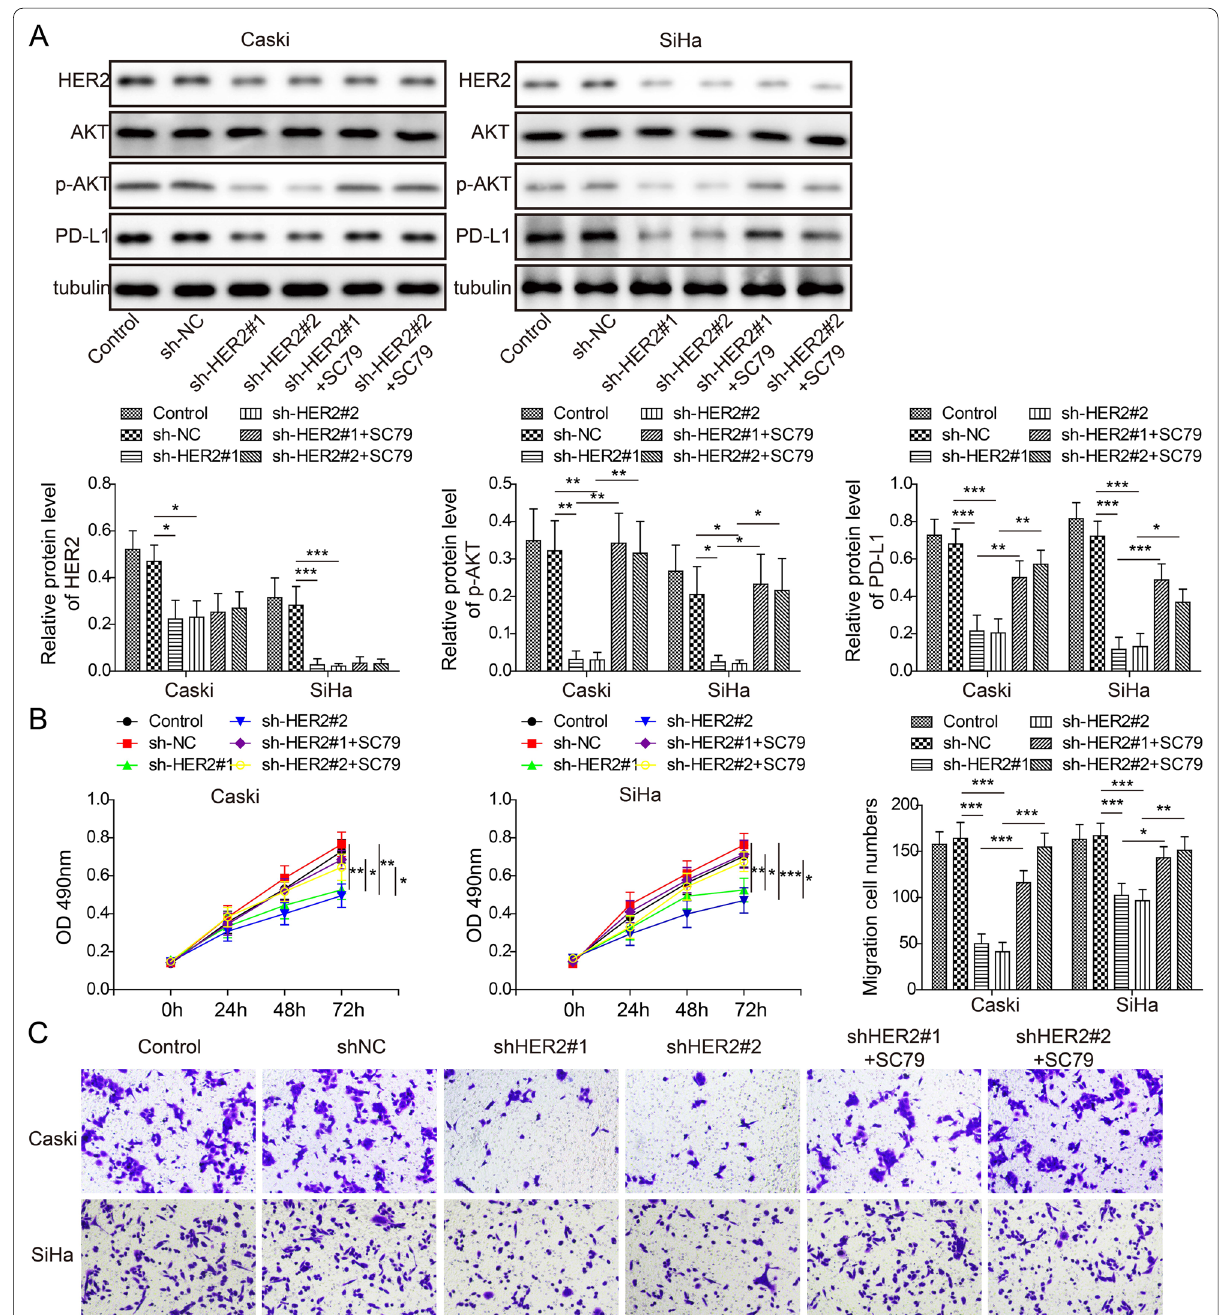
Fig. 4 HER2 increased PD‑L1 expression via PI3K/AKT to promote the proliferation and migration of cervical cancer cells. A Western blotting image and analysis of HER2, AKT, p‑AKT. PD‑L1 and tubulin expressions in control, sh‑NC, sh‑HER2#1, sh‑HER2#2, sh‑HER2#1 treated Caski and SiHa cells. B MTT assay evaluating cell proliferation. C Transwell assay evaluating cell migration. N ** p < 0.01 or *** p <